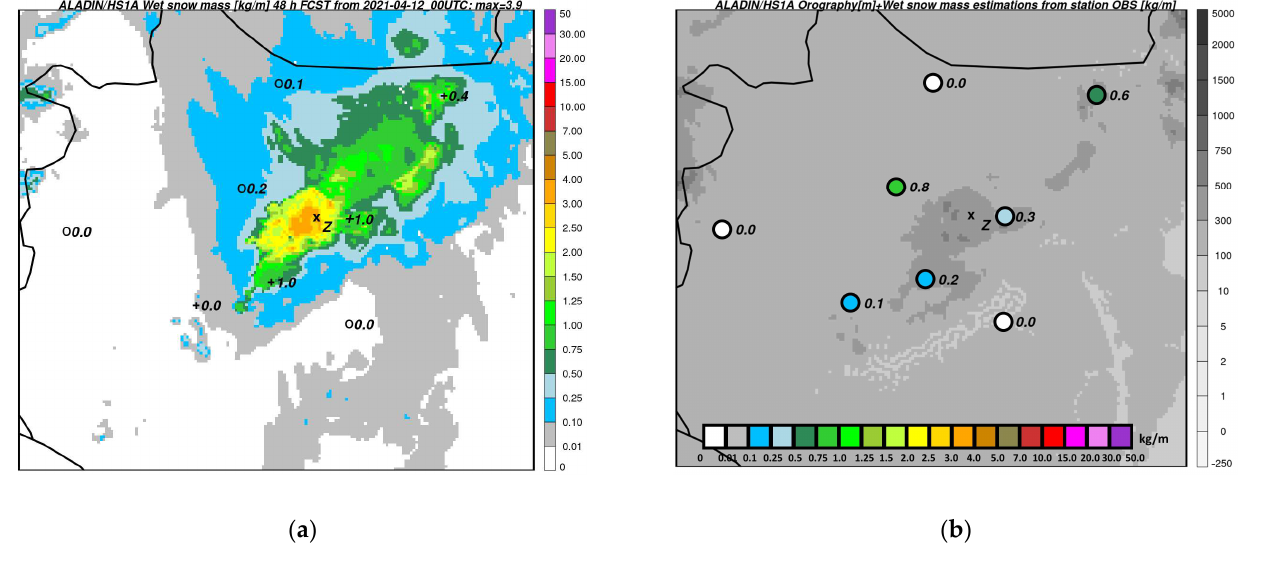
Figure 16. ( a ) as in Figure 15a but for the run based on 12 April 2021 00 UTC and valid for 14 April 2021 00 UTC and for northwestern Hungary.; ( b ) ALADIN/HS1A model orography (shaded, m). Numbers represent the station observation and NWP-based estimations of wet snow mass (kg·m −1 ) cumulated for the same period and with the same setup of wet snow density (500 kg·m −3 ) as in ( a ). Compare with the reference ALADIN/HS1A results presented in Figure 13c,d.